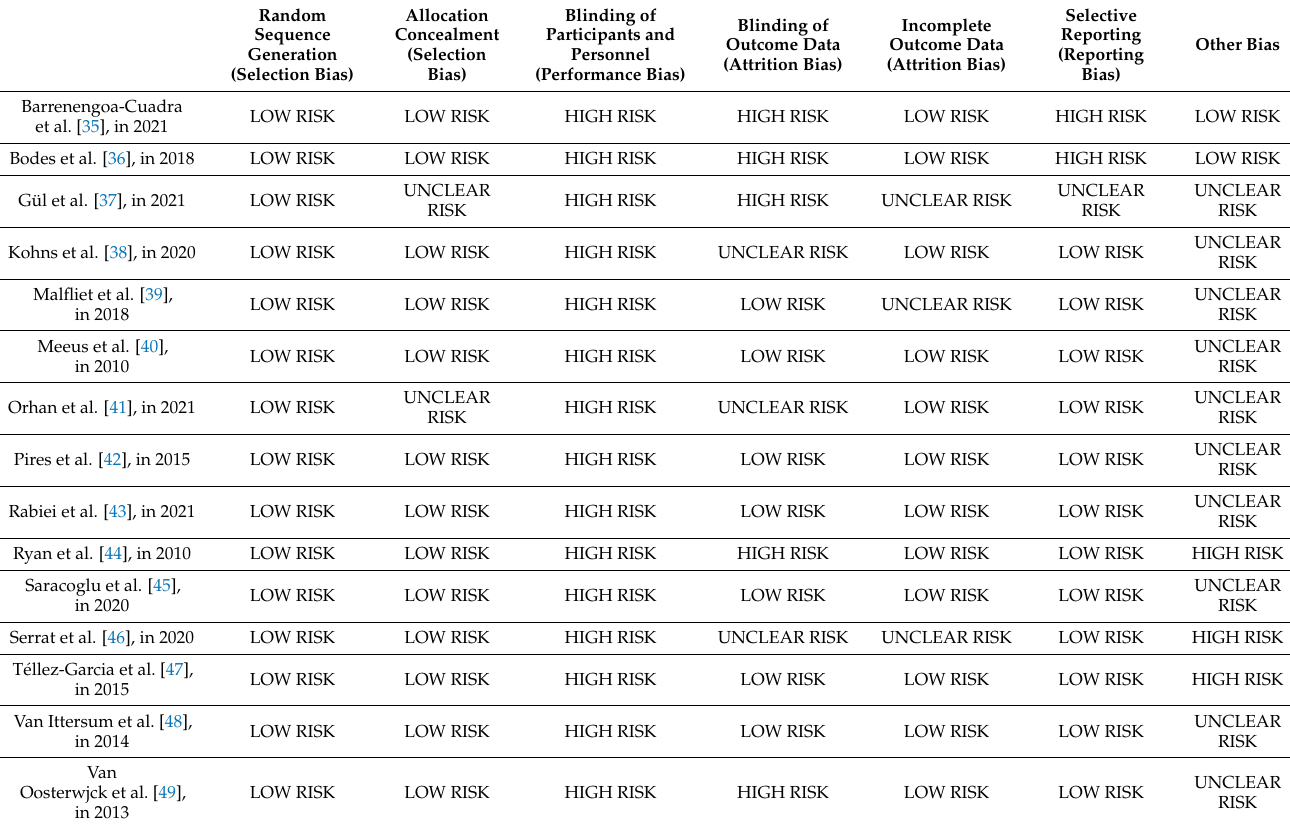
Table 4. Risk of bias.